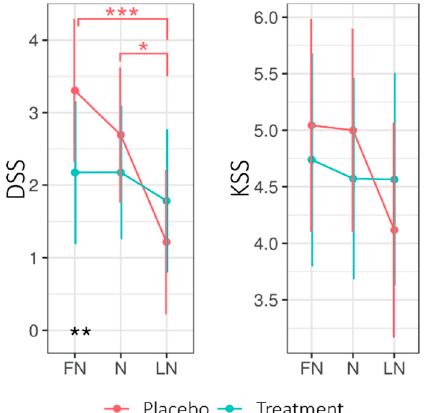
Figure 2. Estimated marginal means for Driver Sleepiness (DSS) and Sleepiness (KSS) for the commute home for the treatment and placebo condition across nightshift days. Higher values indicate higher levels of sleepiness on both scales. Error bars indicate the 95% confidence intervals of the estimated marginal means. * = p < 0.05; ** = p < 0.01, *** = p < 0.001. FN = first night of nightshift, N = nightshift, LN = last night of nightshift.